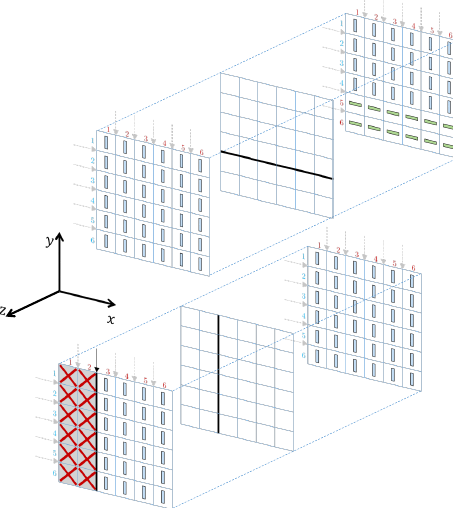
Figure 15: Defect cross: The first reference layer (top right) contains two vertical regions of x and y blocks, the second layer contains only y blocks, and the third (bottom left) contains two horizontal regions of y and z blocks. In the transition between the first (second) and second (third) layers, along the boundary between the vertical (horizontal) regions, the x ( y ) edges receive one (three) red line contribution and hence a defect line is formed parallel to the x ( y ) direction. The rows in the top region before the first transition, as well as all the rows after the second transition can be swapped without changing the resulting defect locations.